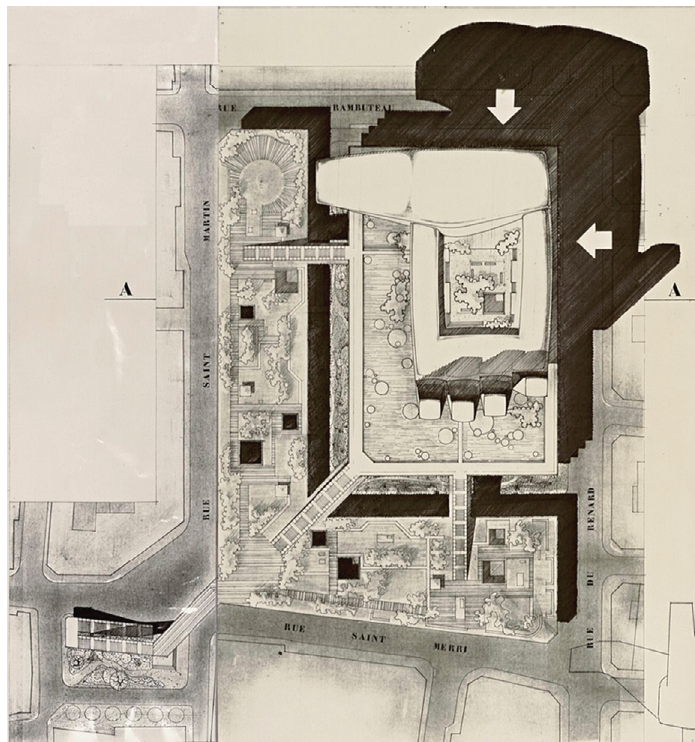
Figure 6. Bergerioux, André. Project No 006. Aerial Plan.